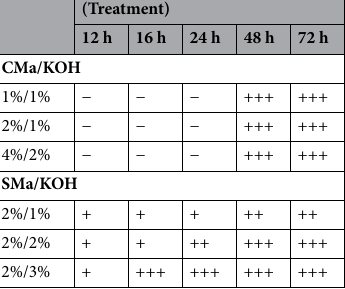
Table 1. Effects of CMa/KOH and SMa/KOH effects on hair removal. CMa calcium mercaptoacetate, SMa sodium mercaptoacetate.